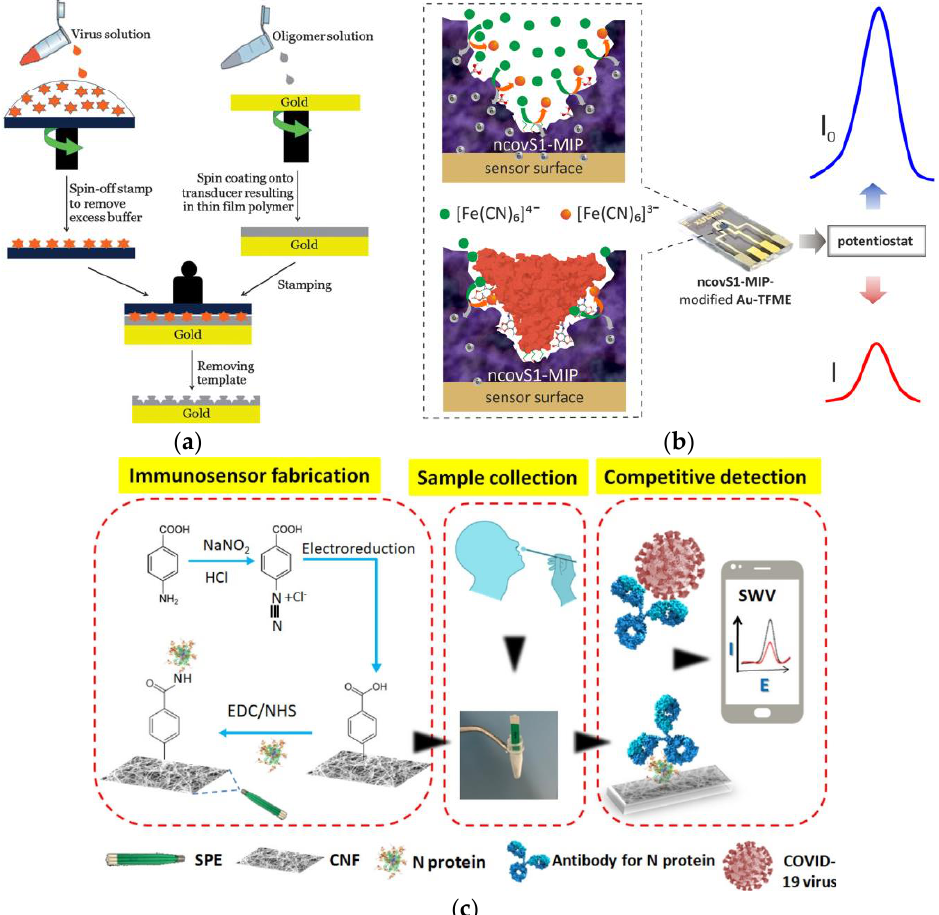
Figure 3. ( a ) Schematic representation of the imprinting protocol used to apply on the quartz crystal microbalance (QCM) as a biosensor. (Reprinted with permission from [97]. Copyright Royal Society of Chemistry, 2013). ( b ) The operating principle of the ncovS1 sensor in COVID-19 diagnosis, where the redox probe readily carries the charge through ncovS1-MIP to produce current (I0), and the rebound ncovS1 blocks pathways for the redox probe to carry the charge through ncovS1-MIP leading to a concentration-dependent contraction in the recorded current (I). (Reprinted with permission from [98]. Copyright Elsevier, 2022). ( c ) Schematic representation of the cotton-tipped electrochemical immunosensor for COVID-19. The sample collection is made by using the cotton-tipped electrode, the functionalization of the carbon nanofiber electrode is made by using electroreduction of diazonium salt and by attaching the virus antigen, and the detection principle is made by using a competition assay and the SWV technique. (Reprinted with permission from [99]. Copyright American Chemical Society, 2020).